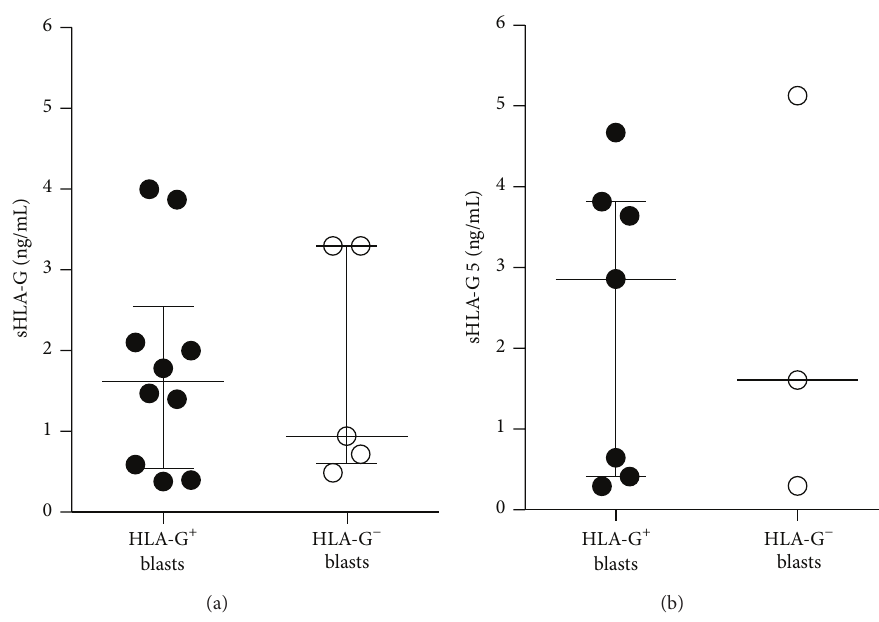
Figure 4: Soluble HLA-G levels in the sera of AML patients. The concentration of (a) sHLA-G (shed HLA-G1 and HLA-G5) and (b) HLA-G5 in the sera of AML patients was evaluated using specific sandwich ELISA. Each dot represents single AML patient. Lines indicate the median of serum levels (ng/mL) of positive samples in patients with HLA-G + or HLA-G − blasts.